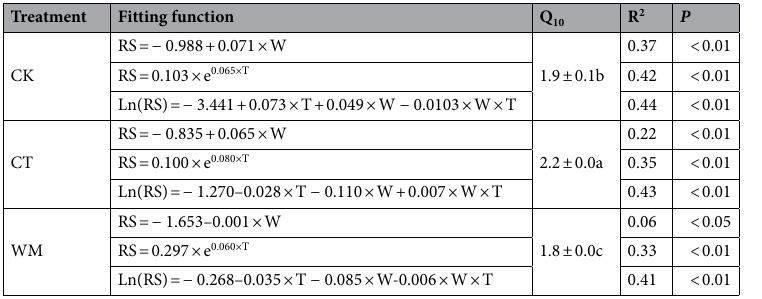
Table 3. Correlations of seasonal soil daytime respiration with the soil temperature and soil moisture. RS, soil respiration; T, , soil temperature; and W, soil water content. Different letters in the same column indicate significant variance by T-test at p <